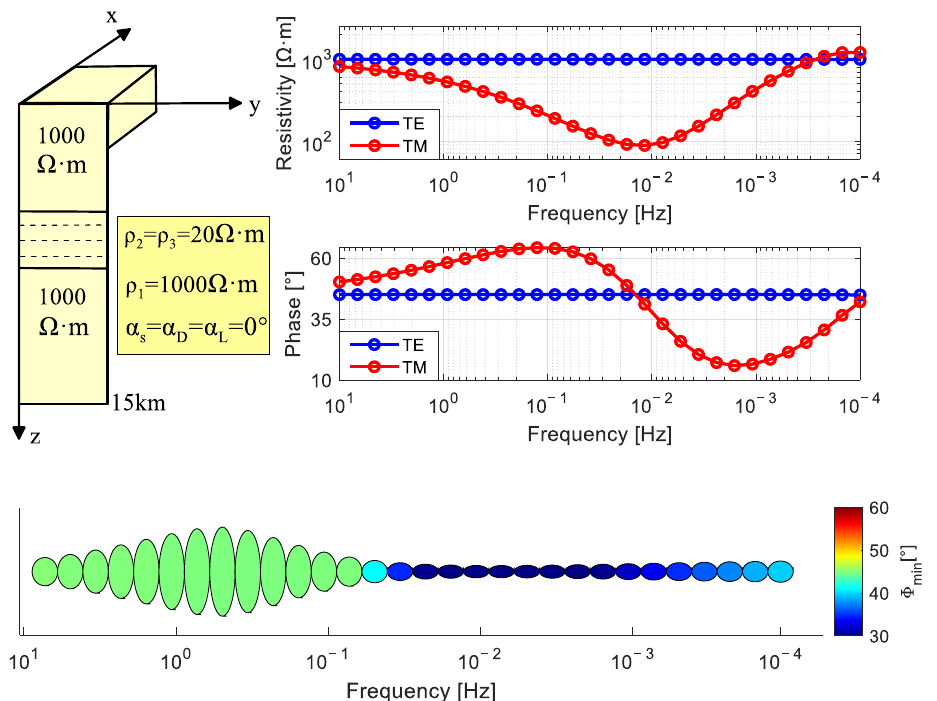
Figure 5. Interlayer anisotropy media, apparent resistivity, and phase tensor results.